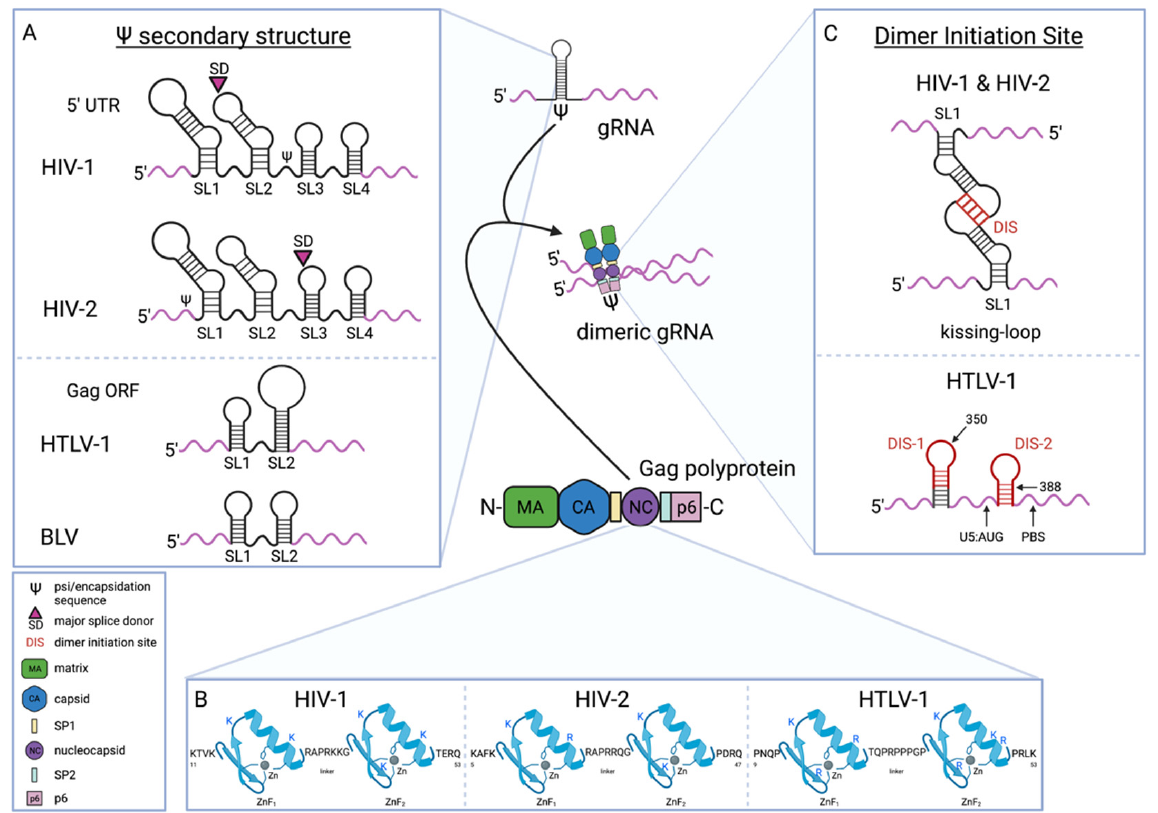
Figure 3. Schematic representation of the human retroviral gRNA packaging process. Gag stabiliza- tion of retroviral genome dimers which occurs between two Gag-gRNA duplexes. ( A ) HIV-1 and HIV-2 RNA secondary structure models of the 5-untranslated region (5 ′ UTR) containing the psi ( Ψ ) sequence with indication of the major splice donor site (SD) either upstream to the Ψ sequences necessary for packaging, as in HIV-1 or downstream to the Ψ packaging sequences as in the case of HIV-2; HTLV-1 and BLV RNA secondary structure models of the gRNA packaging sequence are located in the Gag open reading frame (ORF). The RNA structural elements are marked as indicated: SL1, stem-loop 1; SL2, stem-loop 2; SL3, stem-loop 3; SL4, stem-loop 4; gRNA, viral genomic RNA. Stem-loops are not drawn to scale. ( B ) Model of the structural motifs in the retroviral Gag polyprotein nucleocapsid (NC) domain mediating the specific Gag-gRNA interaction. Shown are the two zinc- finger (ZnF 1 and ZnF 2 ) motifs in HIV-1, HIV-2, and HTLV-1 NC (amino acid residues 11–53, 5–47, and 9–53 respectively). During HIV-1 gRNA packaging, both ZnFs are necessary as the predominant interacting partners with the gRNA, yet the N-terminal ZnF has a greater impact on gRNA packaging. Highlighted in blue are the specific, positively charged, basic amino acid residues within the two ZnF motifs that have been identified to be involved in binding the gRNA. ( C ) Representative kissing-loop structure induced by NC of HIV-1 and HIV-2 at the gRNA dimer initiation site (DIS), a palindromic sequence located in SL1 of the Ψ sequence secondary structure in the 5 (cid:48) UTR; representative structure of the two DIS sites identified for HTLV-1 containing palindrome-like sequences located within loop structures in the 5’ leader sequence upstream of the primer binding site (PBS). Created with BioRender.com software (accessed 4 May